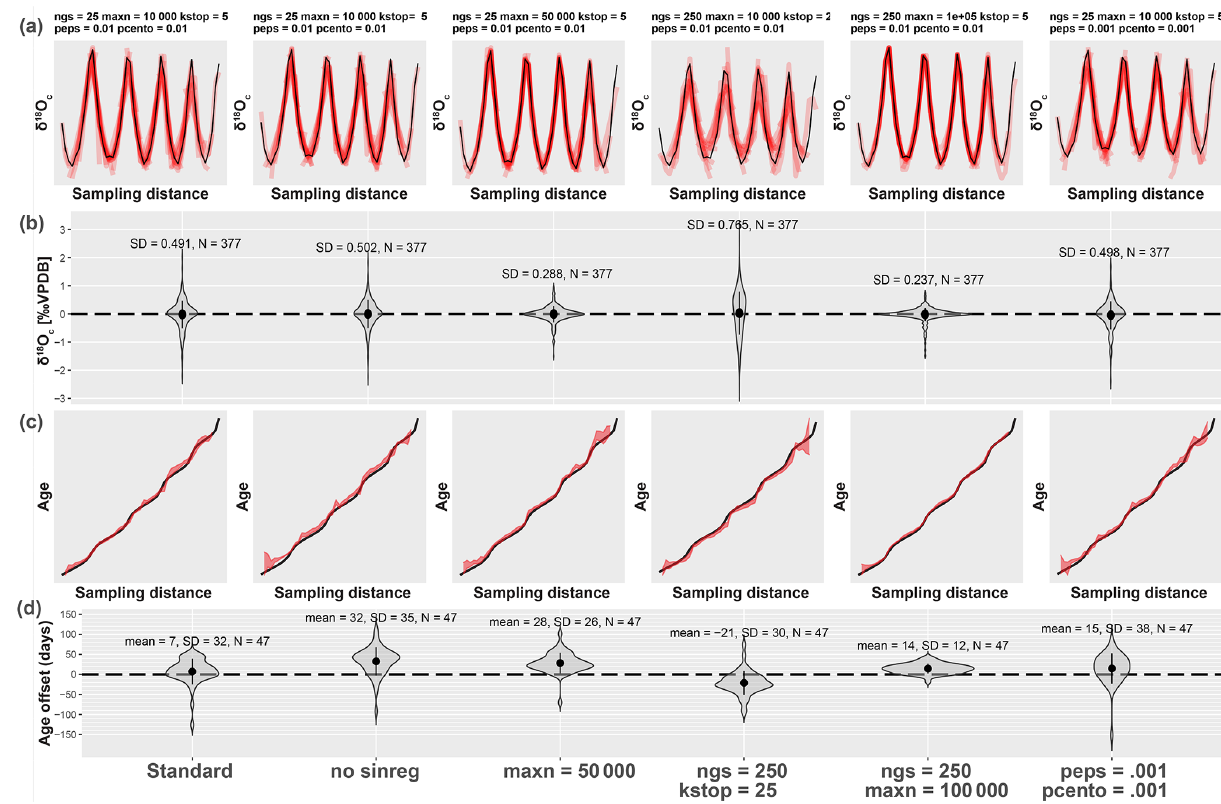
Figure 5. Result of testing ShellChron with various combinations of SCEUA parameters and sinusoidal regression on the test case dataset (see Fig. 2). The leftmost plots illustrate performance of ShellChron under default SCEUA parameters. Plots to the right show various combinations of parameters that deviate from the default (see labels on top and bottom of plot). (a) Fits of the model δ 18 O c curves (red) with the data (black). (b) Violin plots showing the distribution of modeled δ 18 O c offset from the data. (c) Age–distance plots showing modeled (red) and known (black) age–depth relationships for each scenario. (d) Violin plots showing the distribution of age offsets from the known age–depth relationship. SD: standard deviation, N : number of data points, sinres: sinusoidal regression; maxn, ngs, kstop, peps, and pcento are SCEUA parameters (see Duan et al., 1992, and explanation in Sect. 4.1). Data on test results are provided in